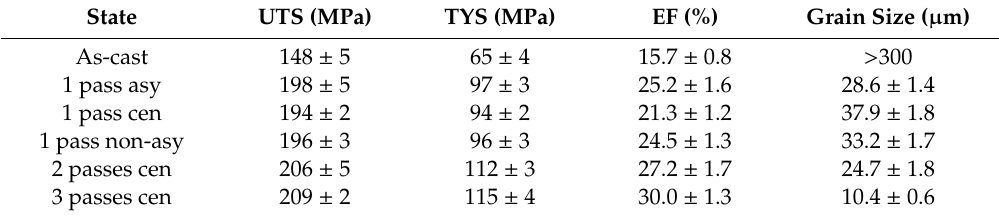
Figure 11. Engineering stress–strain plots for AZ31B alloys with and without CEE-AEC processing at room temperature (The di ff erent lines represent di ff erent sampling positions and states of AZ31B alloys processed by CEE-AEC, and the dog-bone shaped tensile sample is shown in the bottom of the figure). Table 2. Room temperature tensile properties of AZ31B alloys without and with CEE-AEC passes. Asy: asymmetrical area; cen: center area; non-asy: non-asymmetrical area; UTS: ultimate tensile strength; TYS: tensile yield strength; EF: elongation to